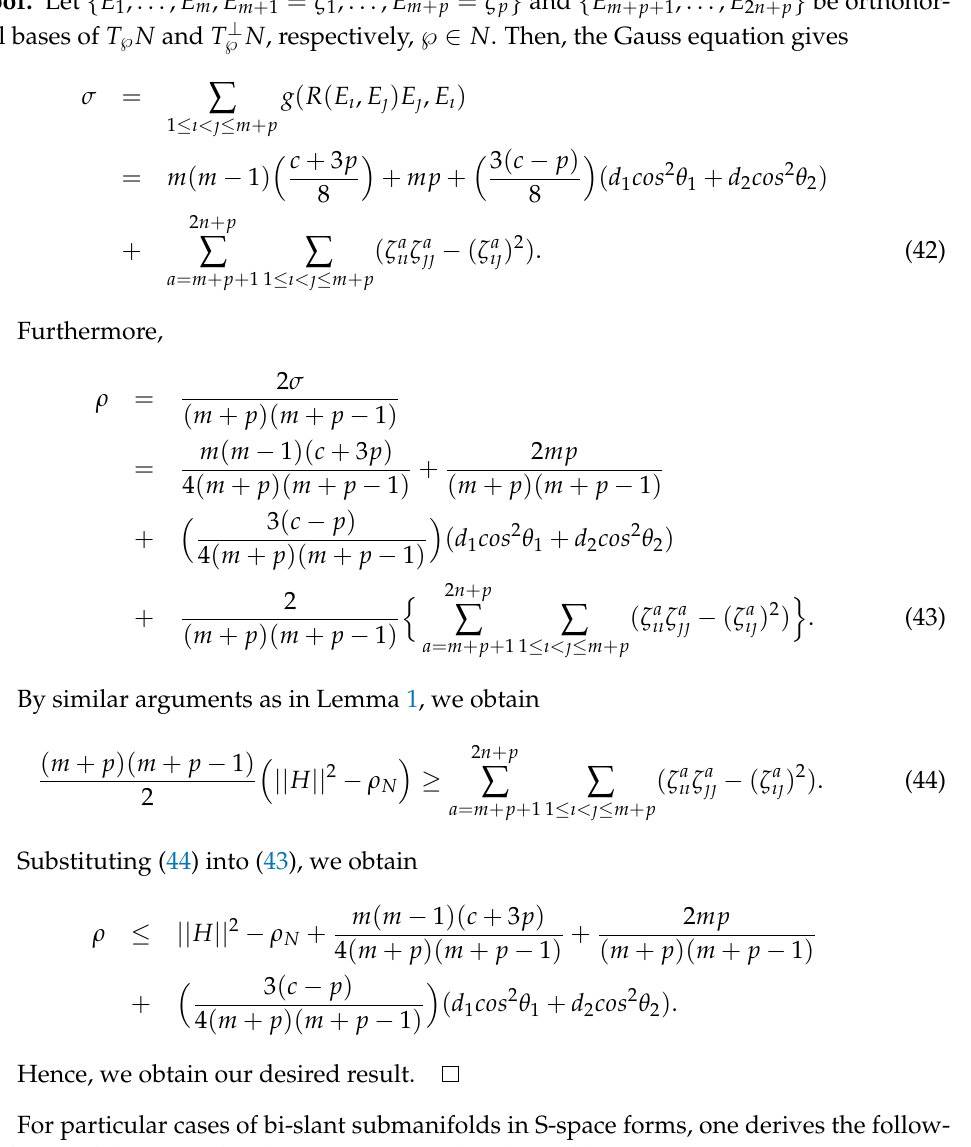
Table 3. The forms of the DDVV inequality for different submanifolds.